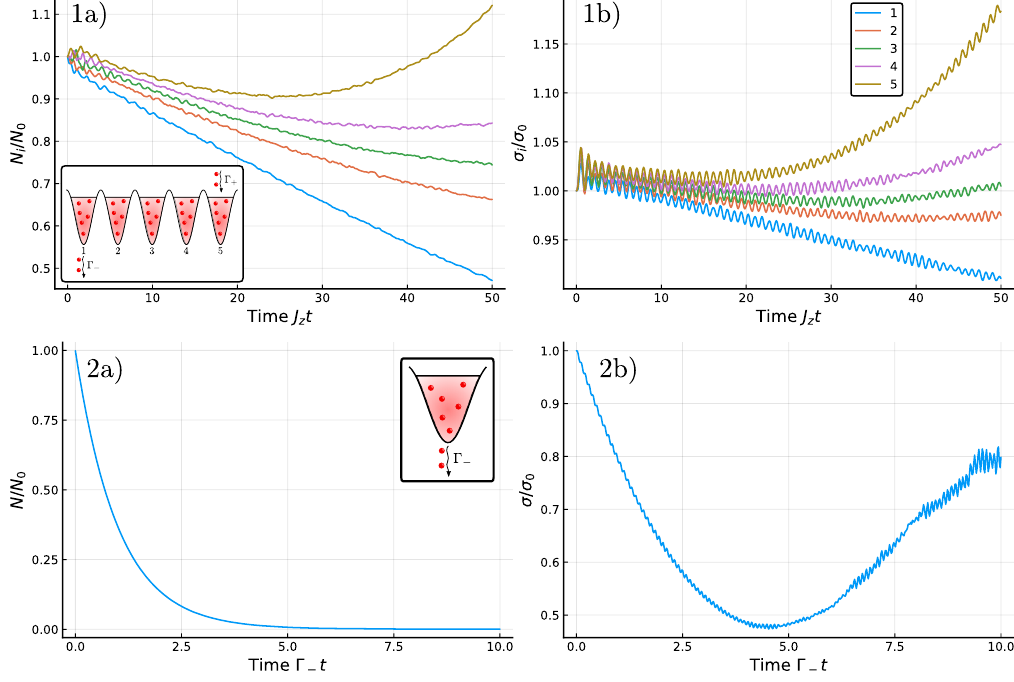
Figure 6: Condensate dynamics with incoherent gains and losses. 1a) Occupation numbers of 5 coupled condensates on a 1D lattice. The leftmost condensate is sub- = 0.1 and the rightmost to an incoherent gain of jected to a loss rate of Γ − / J z Γ / J = 0.05. All other parameters are taken from Sec. 5.1. 2a) Depletion of the + z = 0.1 and Γ = 0. 1b) and 2b) occupation number of a single condensate with Γ − / V + r show the respective transversal